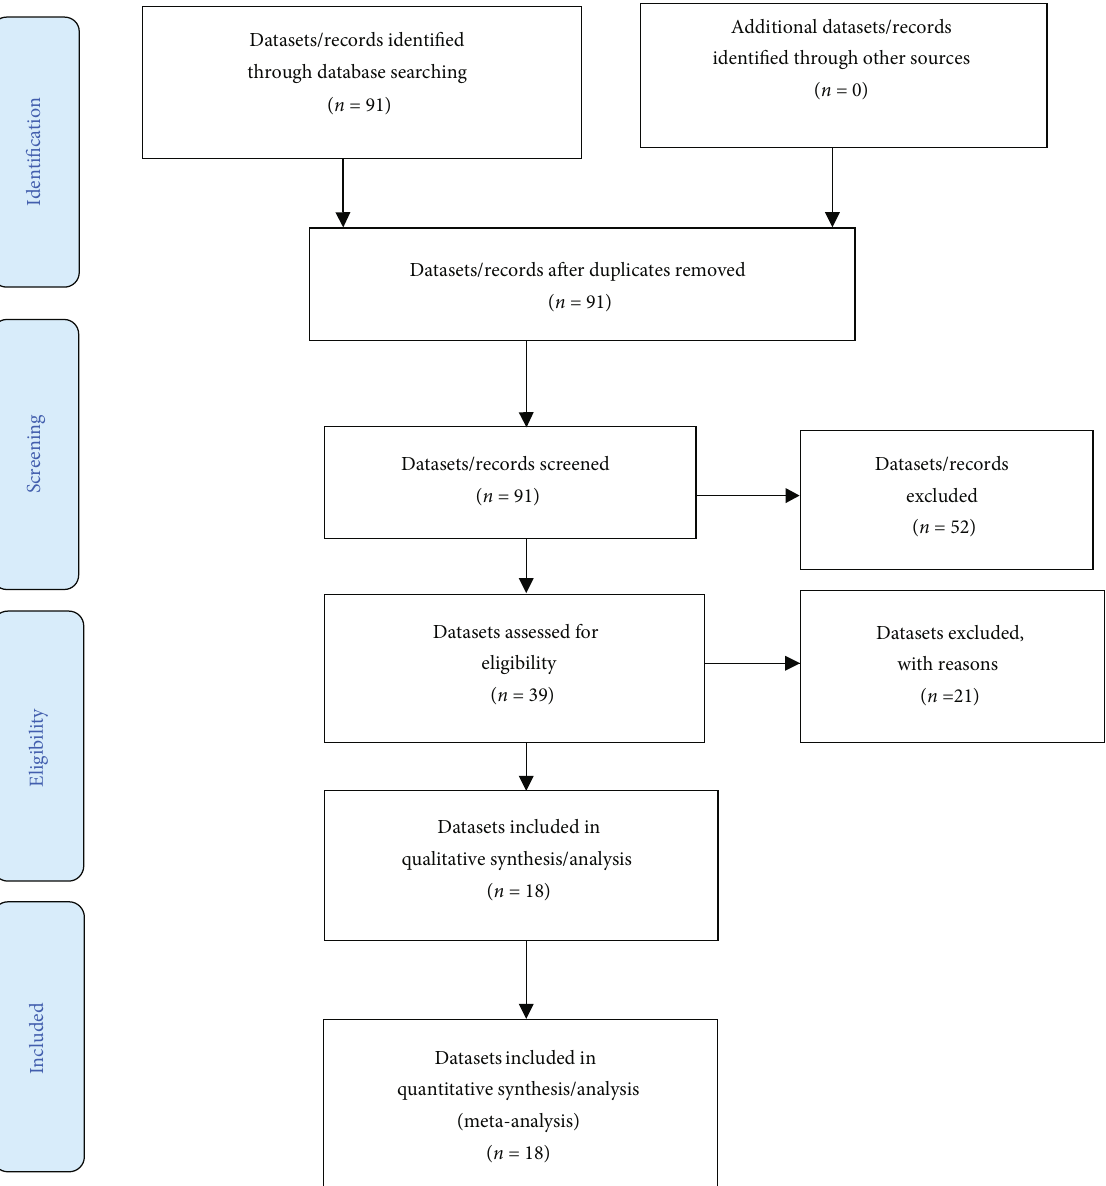
Figure 1: PRISMA (Preferred Reporting Items for Systematic Reviews and Meta-Analysis) fl ow diagram for the eligibility criteria of the datasets. We get a clear illustration of identifying and including DHS datasets for the random e ff ects